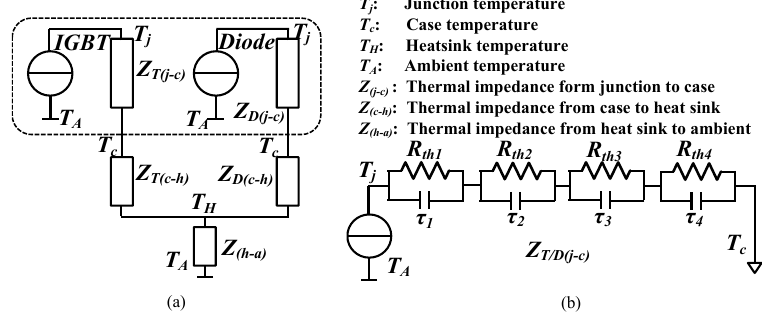
Figure 5. Thermal model: ( a ) power devices thermal model; and ( b ) IGBT resistor-cpacitor ( RC ) network of Z T/D(j-c) . Table 3. Module thermal parameters.